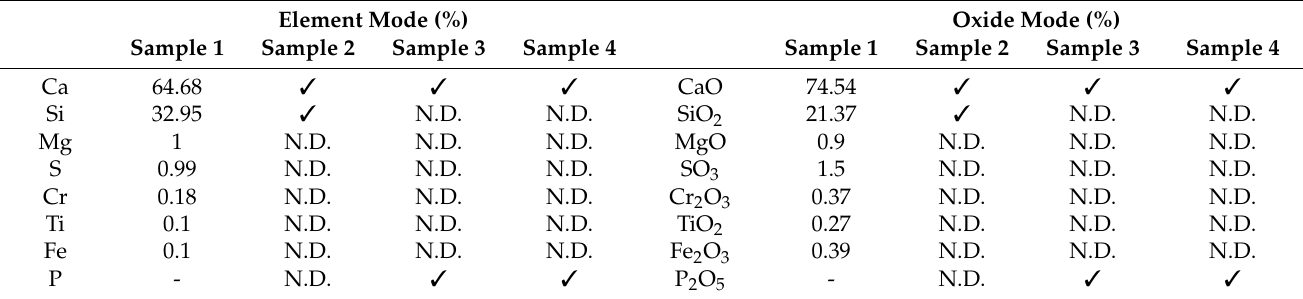
Table 2. XRF data of element and oxide modes in % for different samples are measured.